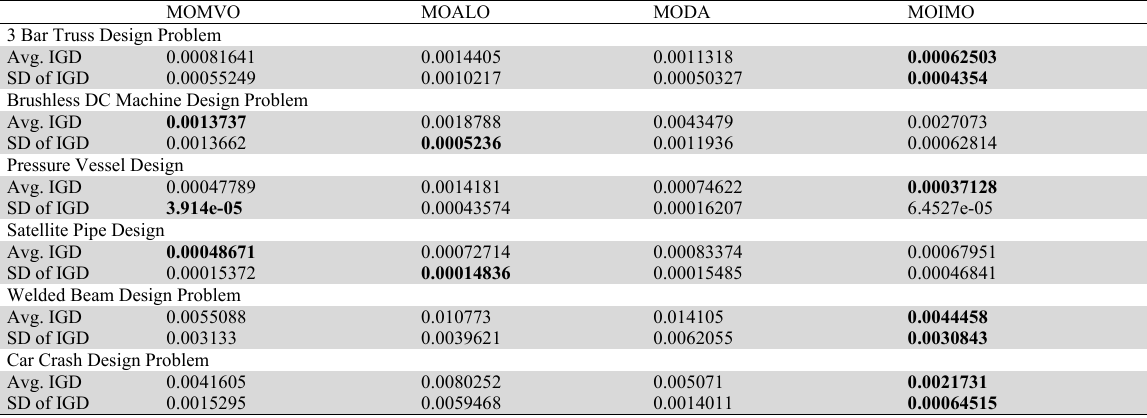
Fig. 4. Best Pareto front for real-world engineering benchmark functions Outcomes of the multiobjective algorithm (IGD) on the engineering design